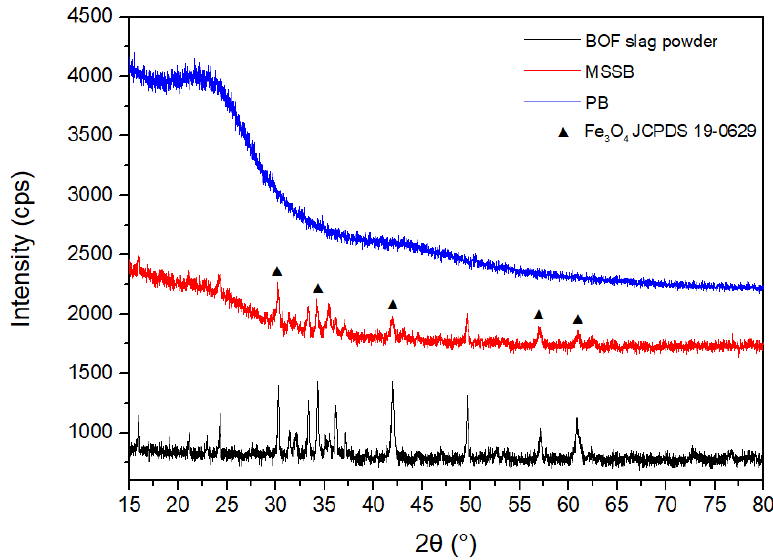
Figure 2. XRD peak patterns of PB, MSSB, and BOF slag powder.